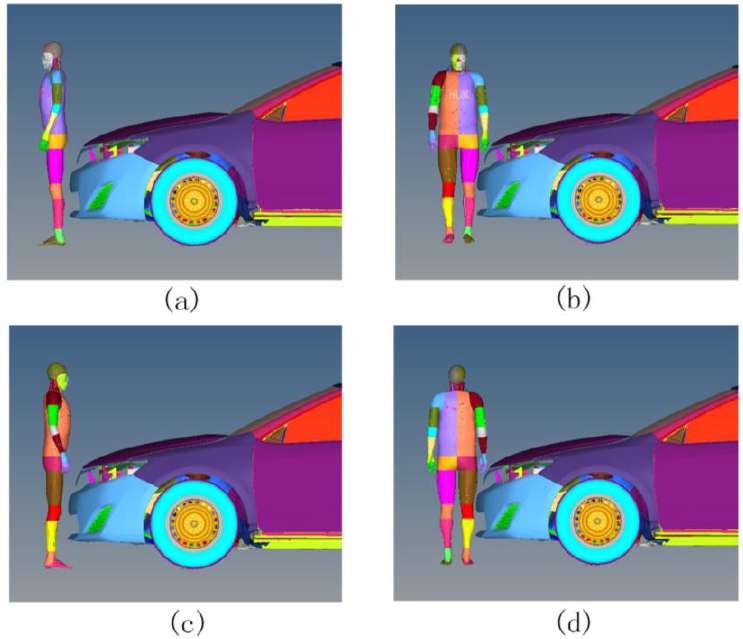
Figure 3. Car–pedestrian collision simulations at different contact angles. ( a ) Collision on the back of the head; ( b ) Collision on the left side of the head; ( c ) Collision on the front of the head; ( d ) Collision on the right side of the head.